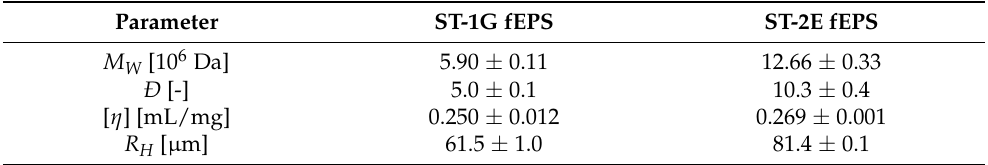
Table 3. Weight average molecular mass M W , polydispersity index Ð , intrinsic viscosity [ η ]